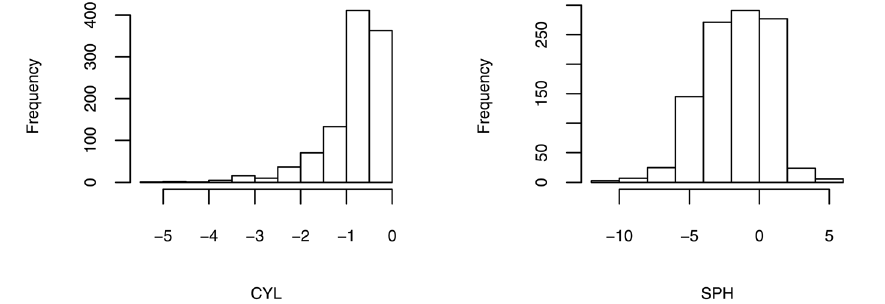
Fig 1. The Histograms of Phenotypes SPH and